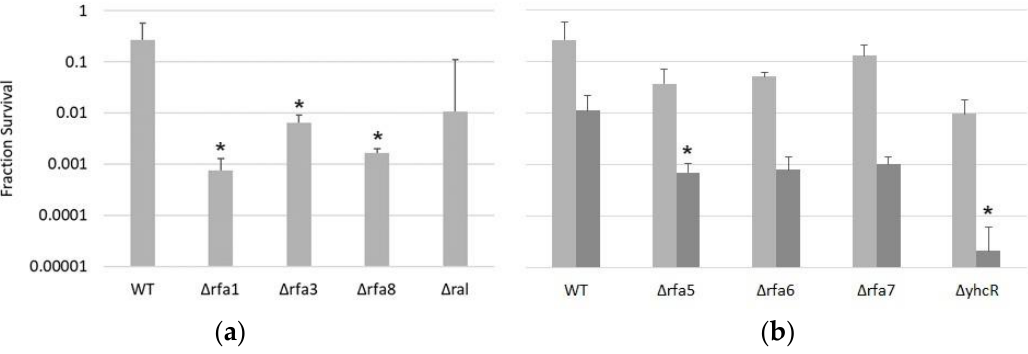
Figure 6. Survival of Hbt. salinarum deletion strains to mitomycin C treatment. ( a ) Survival after 30 min exposure for LH101 (WT), LH140 (Δ rfa1 ), LH134 ( Δ rfa3 ), LH136 ( Δ rfa8 ), and LH138 (Δ ral ). ( b ) Survival after 30 (light grey) and 120 min (dark grey) exposure for LH101 (WT), LH110 (Δ rfa5 ), LH142 (Δ rfa6 ), LH166 (Δ rfa7 ), and LH128 (Δ yhcR ). * p < 0.05 compared to LH101, ANOVA with Tukey’s HSD, n = 3. Error bars represent +/− standard error of the mean.